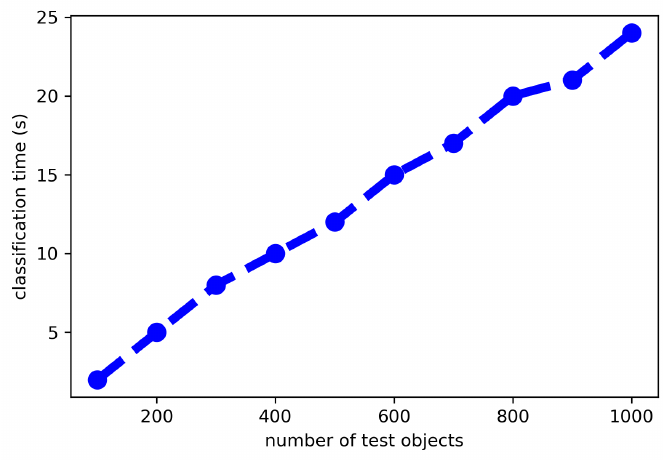
Figure 5. The classification speed of 100 to 1000 test objects by 10,000 rules in the database table. Table 9. Sample of random rules created by the generator for benchmarking purposes. In experiments we use 1000,2000,...,10,000 randomly generated rules.